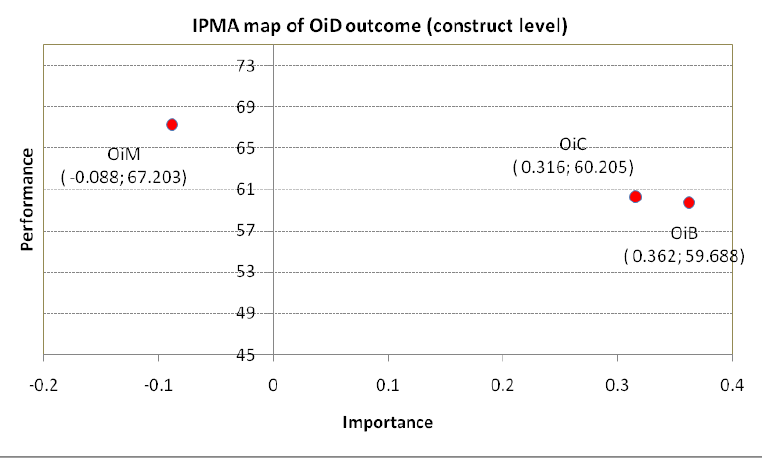
Figure 4. The IPMA map of the target OiD outcome (construct level).